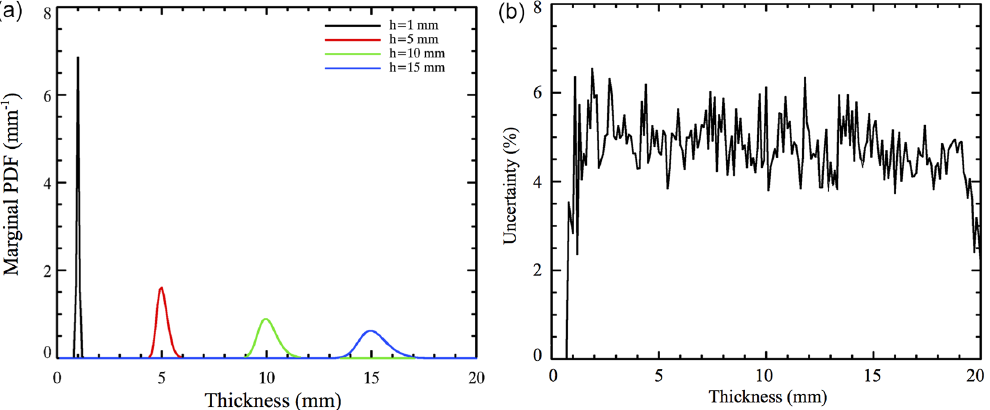
Figure 5. (a) Normalized stacks of 1000 a posteriori PDFs for the thickness of the slab ice layer, when conducting the inversion on synthetic data, with added random noise. The legends indicate the values for the thickness used to create the synthetic data. (b) The a posteriori uncertainty (at 2 σ ) on the thickness estimation as a function of the slab